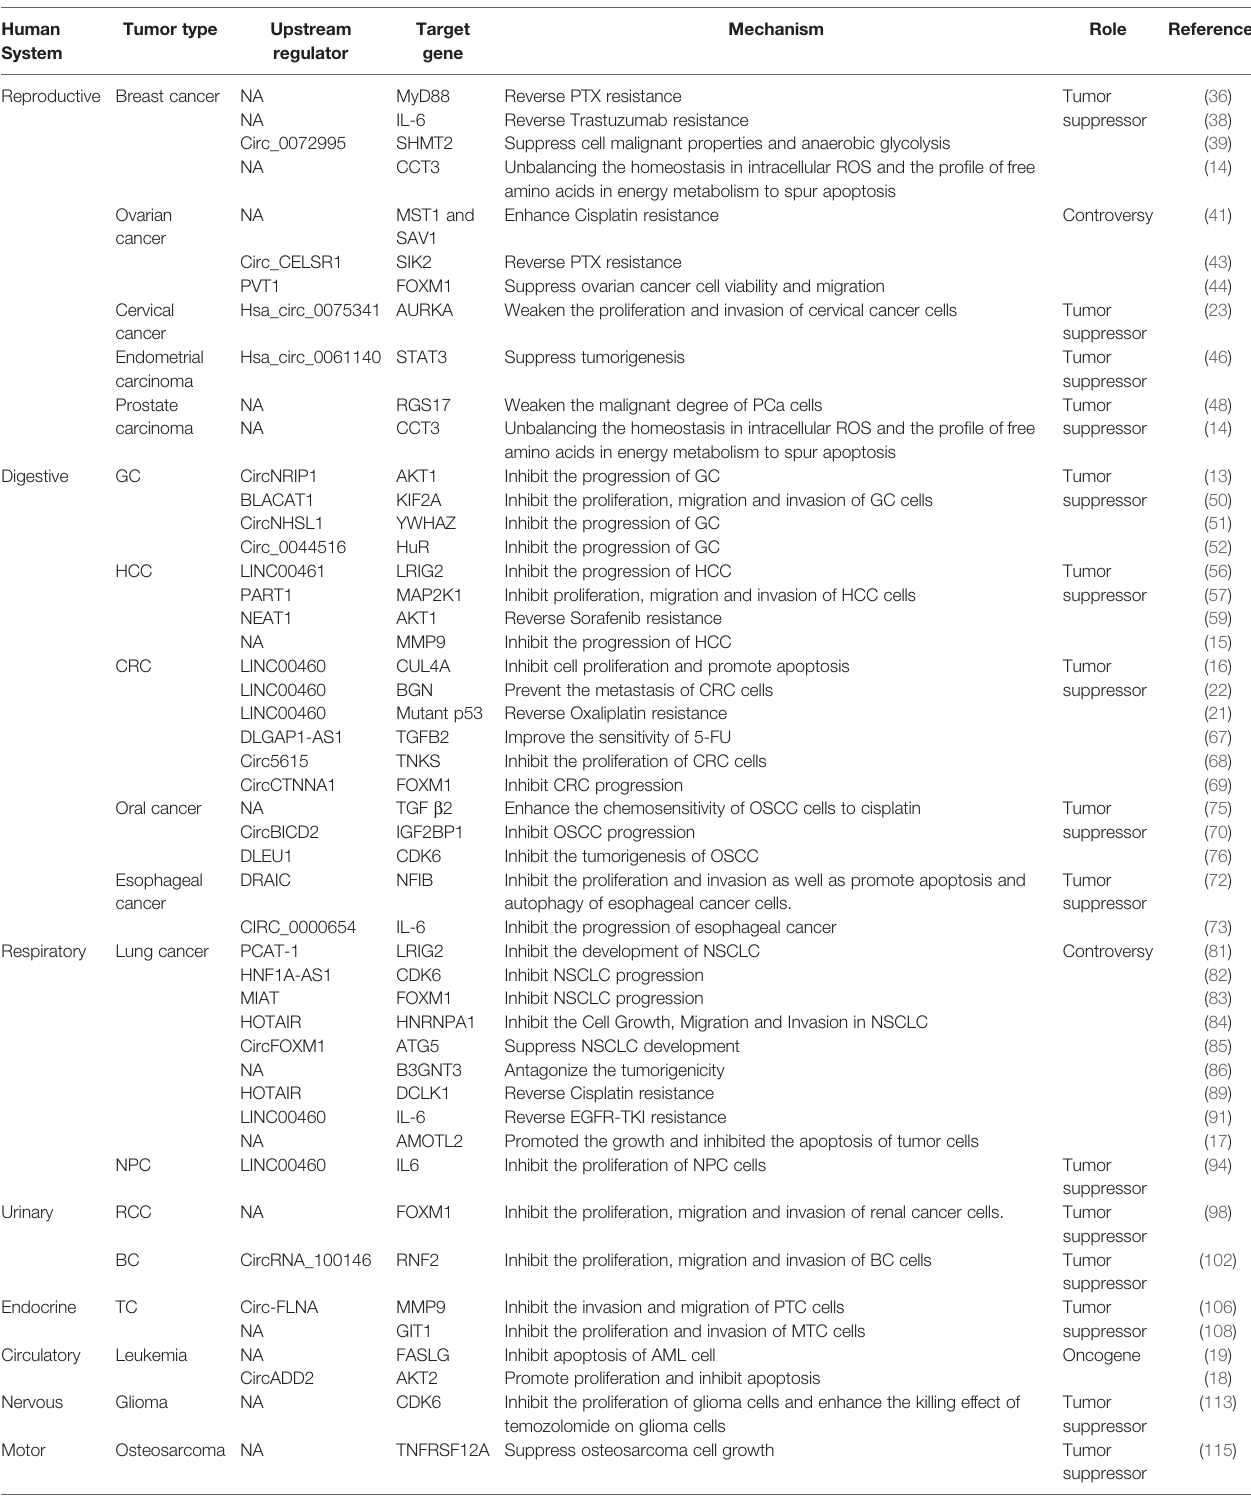
TABLE 1 | MiR-149-5p in different human cancers. Human